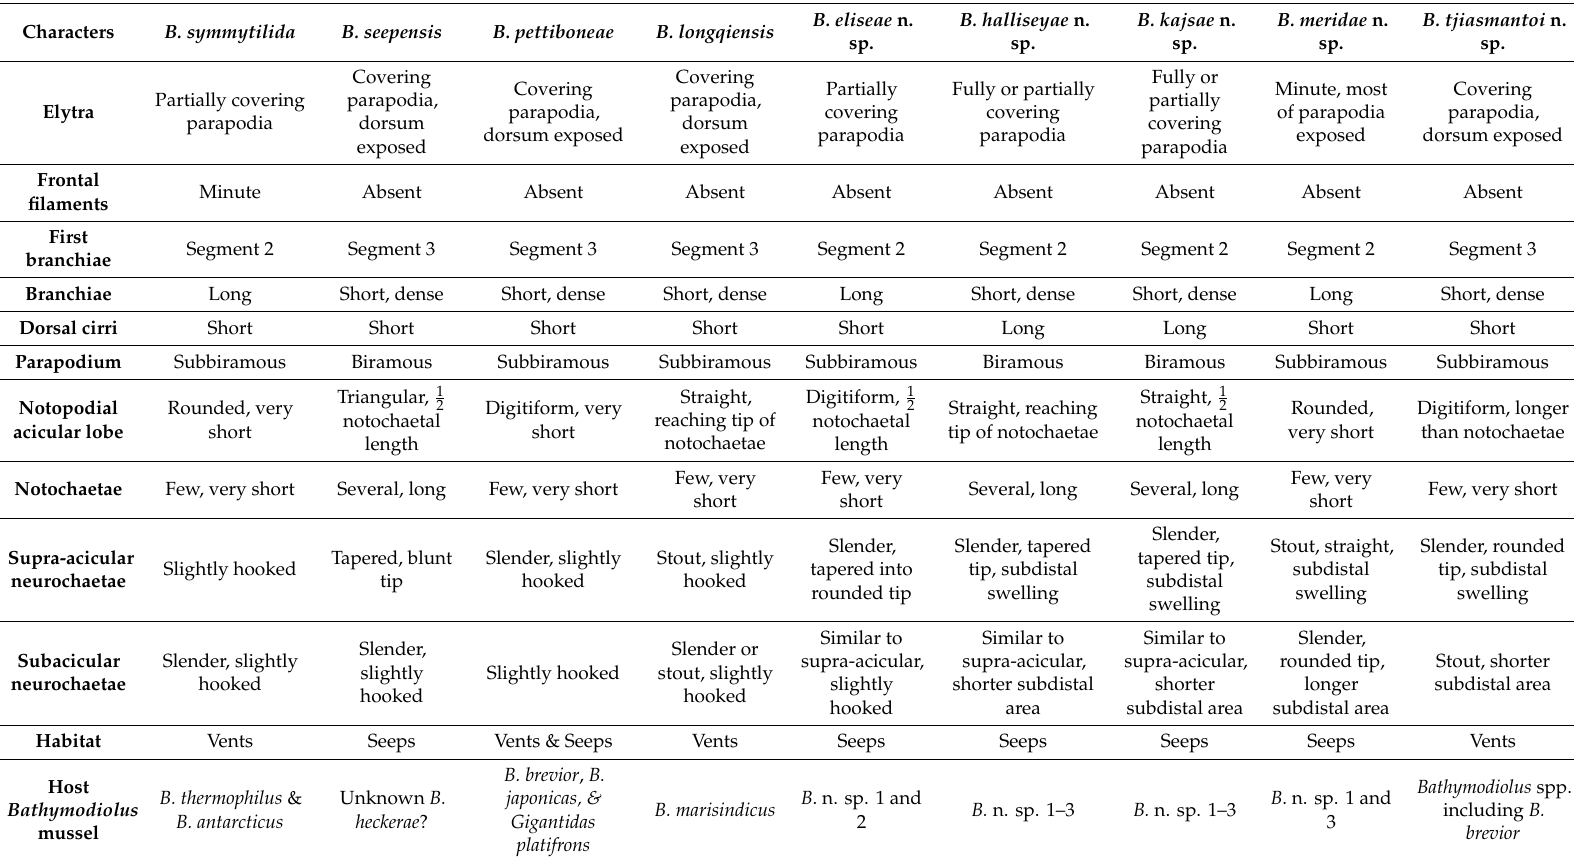
Table 4. Characters of the nine Branchipolynoe